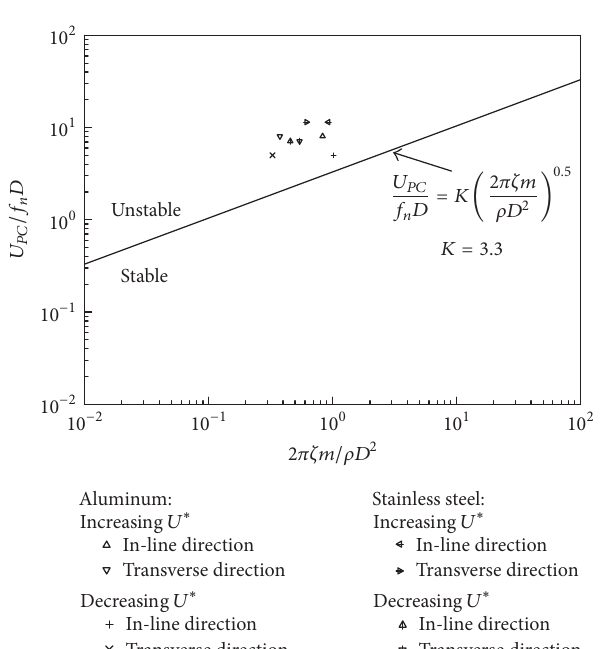
Figure 14: Fluid-elastic instability map for the two parallel triangu- lar tube